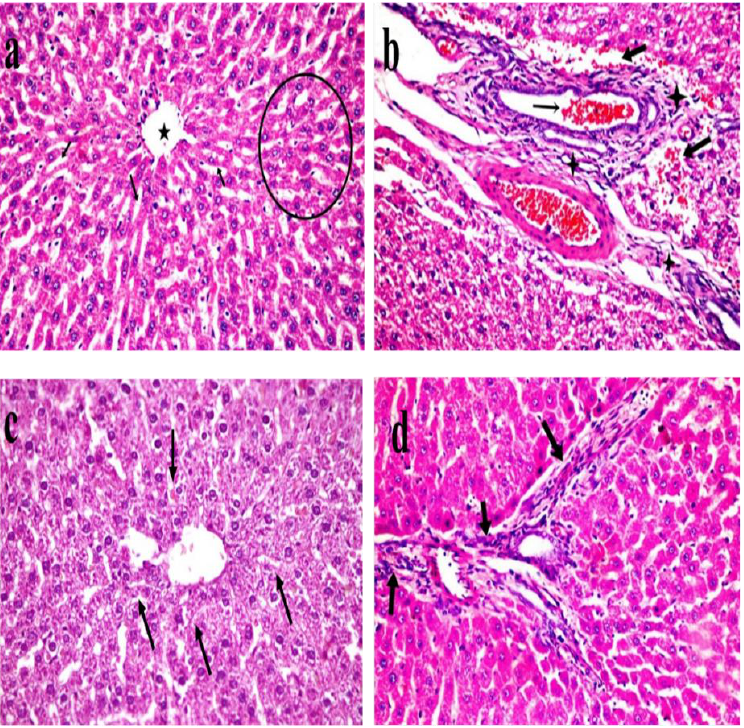
Figure 3. Representative photomicrographs of rat livers. ( a ) Group 1, negative control: normal hepatic parenchymal structures of the central vein (star), hepatic cords (circle), and sinusoids (arrows) containing Kupffer cells. ( b ) Group 2, positive control: portal trade fibrosis (stars) represented by spindle cells proliferation, collagen fibers ad-mixed with erythrocytes, and inflammatory cells (thick arrows) among the blood inside the bile duct lumen (thin arrow). ( c ) Group 3, plain yogurt (10 g/day): massive distribution of slightly vacuolated hepatocytes (arrows). ( d ) Group 4, yogurt with 0.4% aqueous Hawthorn leaf extract (10 g/day): interlobular fibrous bridge (arrows) with normal hepatic cords and sinusoids. Hematoxylin and eosin staining, magnification ×